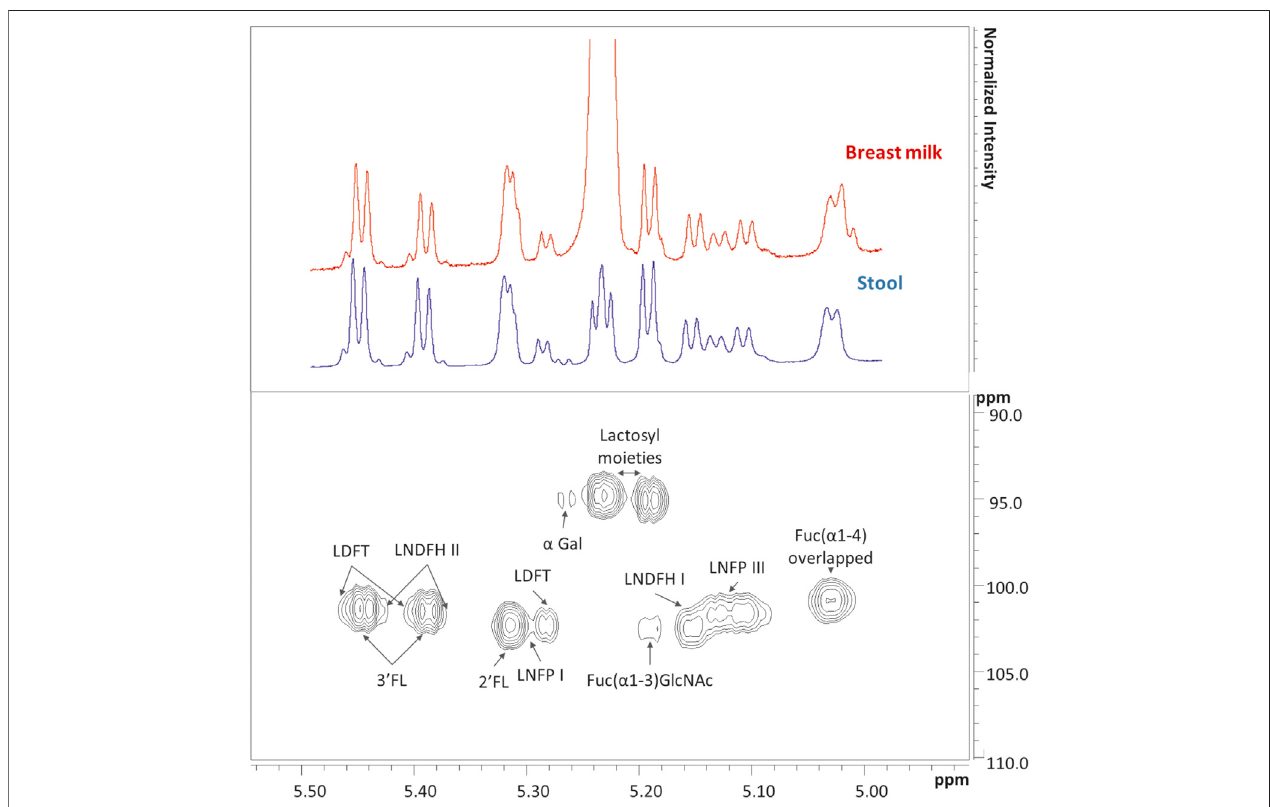
FIGURE 1 | In the upper panel are showed two representatives 1 H NMR spectra of breast milk (red) and infant ’ s stool (blue) collected at day 104 after birth, as focused on the human milk oligosaccharides (HMOs) anomeric region from 5 to 5.50 ppm. The corresponding Heteronuclear Single Quantum Correlation (HSQC) experiment of the stool sample isshowed in the lower panel. In the upper panel, the lactose resonance of breast milk is thehighest inintensity. To better show that most ofthemetabolitesaresharedinthetwobiologicalmatricesatthisspeci fi ctimepoint,acut-offhasbeende fi nedandbothspectrahavebeenscaledinintensity.List of abbreviations: α -Gal, α -galactose; Fuc, fucose; GlcNAc, N-acetylglucosamine; 2 ′ FL, 2 ′ fucosyllactose; 3 ′ FL, 3 ′ fucosyllactose; LDFT, lactodifucotetraose; LNDFH I, II, lacto-N-difucohesaose I, II; LNFP I, III, lacto-N-fucopentaose I,